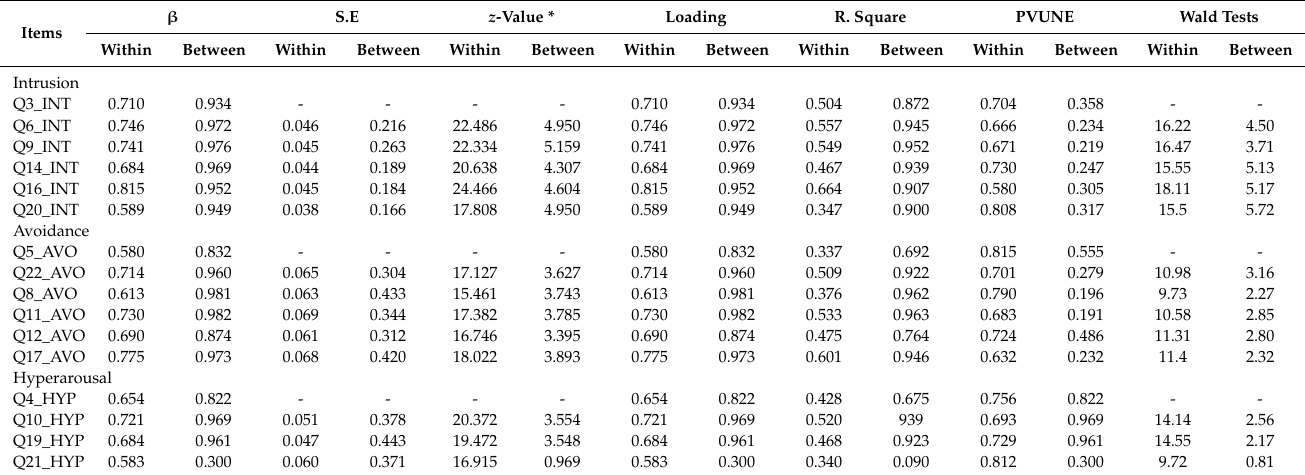
Table 6. Multi-level analysis: within-level model and between-level